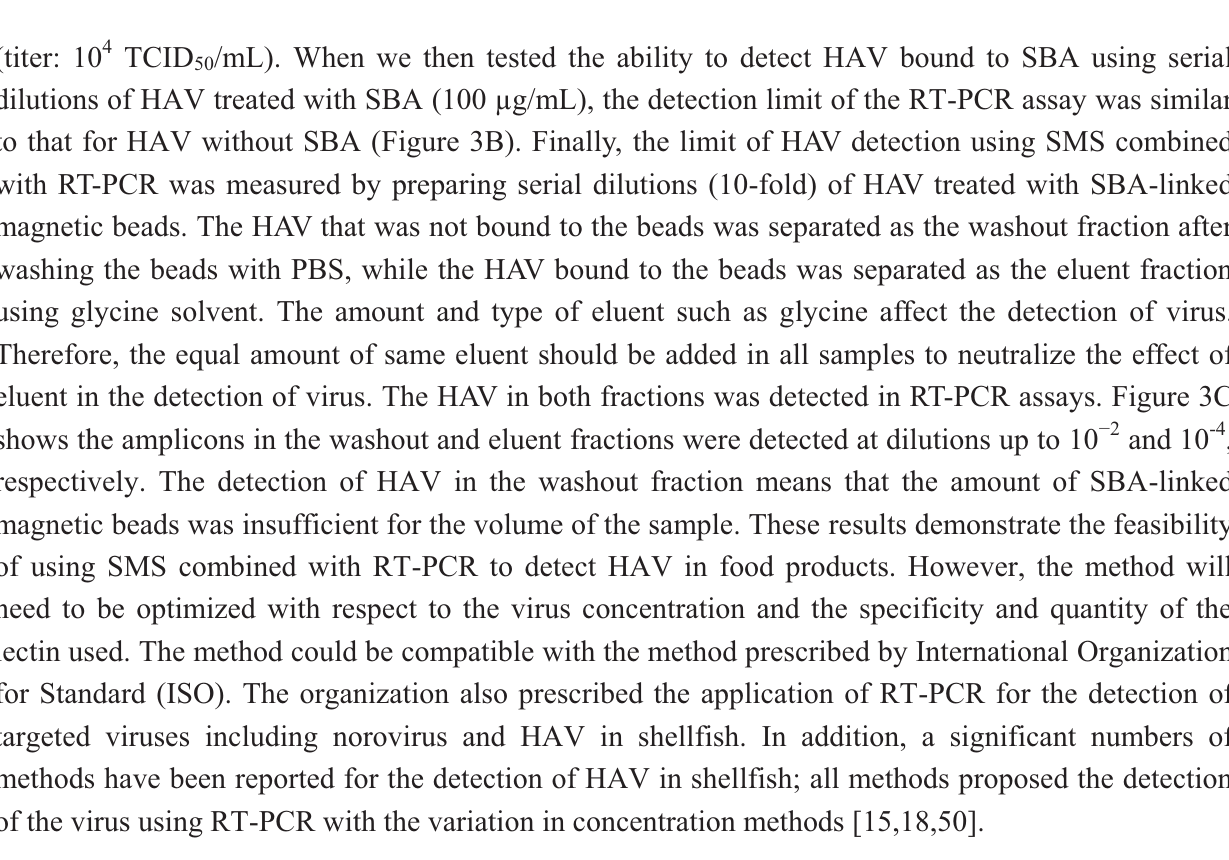
Figure 3. Detection of hepatitis A virus (HAV) using soybean agglutinin-linked magnetic bead separation (SMS) with RT-PCR. ( A ) Determination of the detection limit of HAV using RT-PCR and 10-fold serial dilutions of a HAV stock. M, 100 bp marker; N, negative; ( B ) Determination of the binding of 10-fold serial dilutions (10 − 1 – 10 − 5 ) of HAV stock to soybean agglutinin (SBA); ( C ) Detection of HAV using SMS combined with RT-PCR. The limit of detection for the RT-PCR assay was assessed using 10-fold serial dilutions (10 − 1 – 10 − 4 ) of HAV (267 bp) present in the washout and eluent fractions. M, 100 bp marker; N,